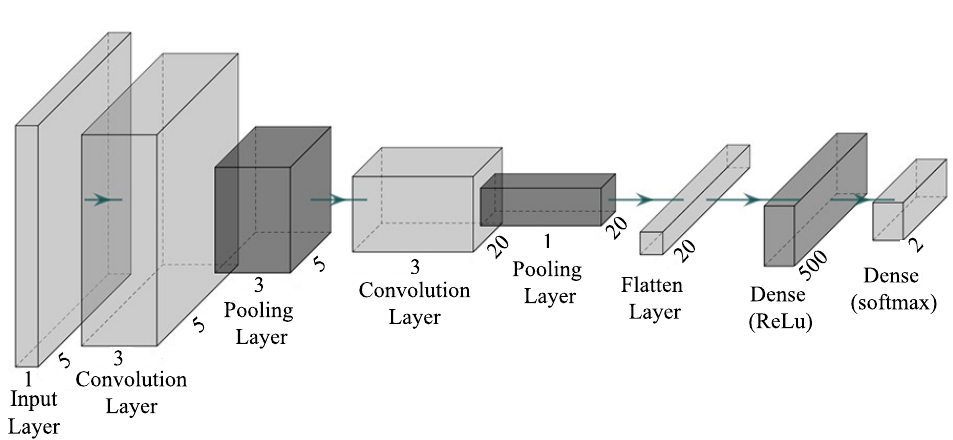
Figure 6. The structure of the proposed P-LeNet